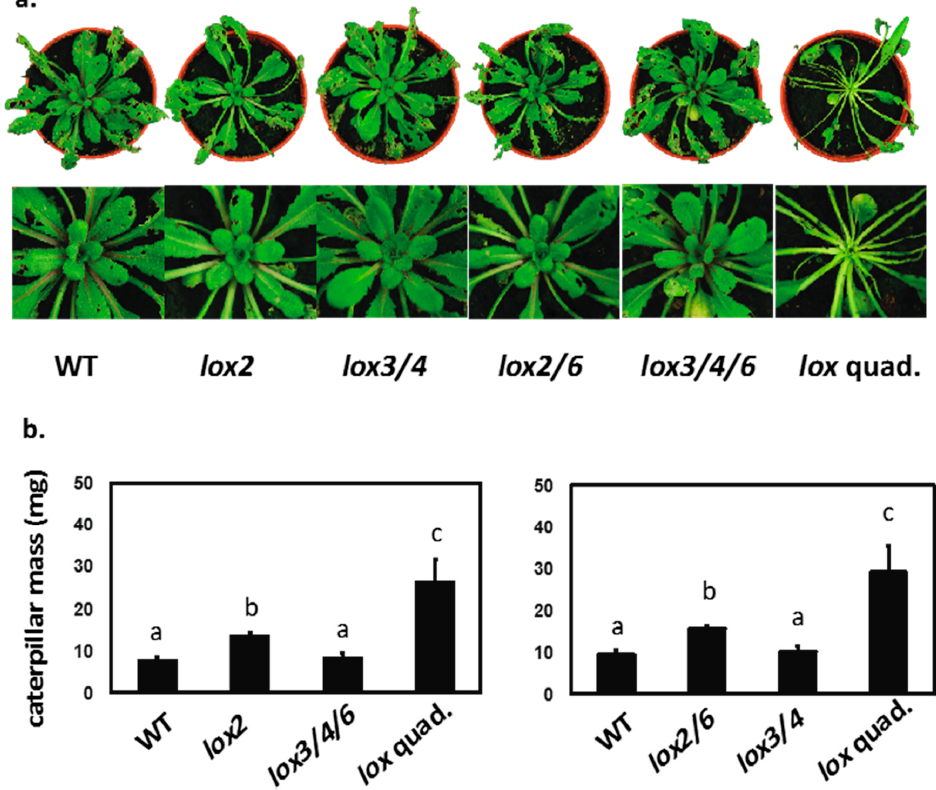
Figure 5. Contributions of 13-LOXs to defense against a chewing herbivore. ( a ) Damage to rosettes inflicted by Spodoptera littoralis larvae. WT = wild type; lox3/4 = the lox3B lox4A double mutant; lox2/6 = the lox2-1 lox6A double mutant; lox3/4/6 = lox3B lox4A lox6A triple mutant; lox quad. = lox2-1 lox3B lox4A lox6A quadruple mutant; ( b ) Larval mass after feeding. Insects were harvested at 11d. Letters (a, b, and c) refer to significant differences (ANOVA and t-test; p < 0.05).